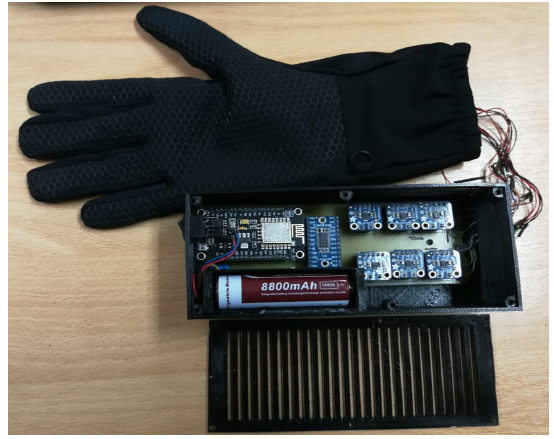
Figure 11. Haptic glove final product.